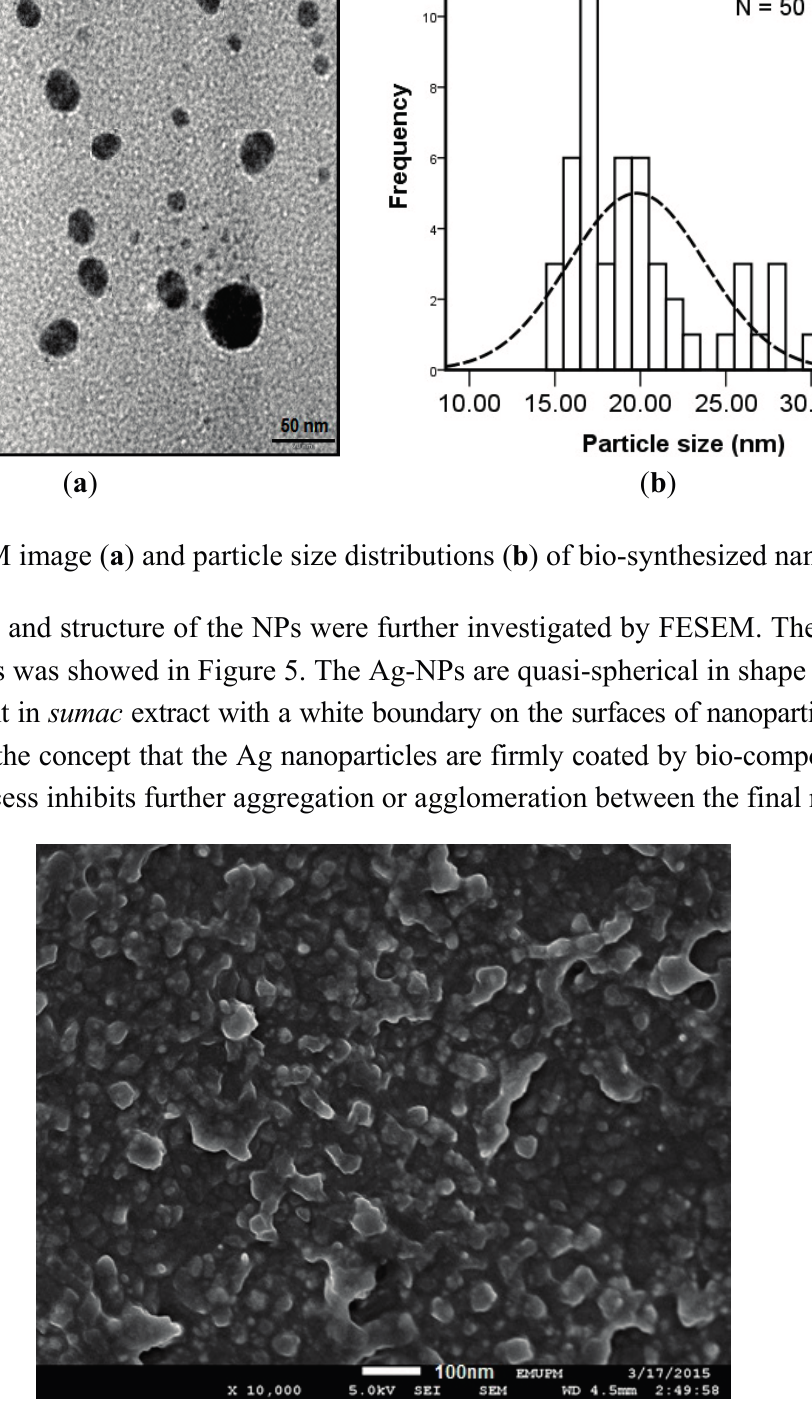
Figure 5. Field emission scanning electron microscopy (FESEM) image of Ag-NPs synthesized using sumac